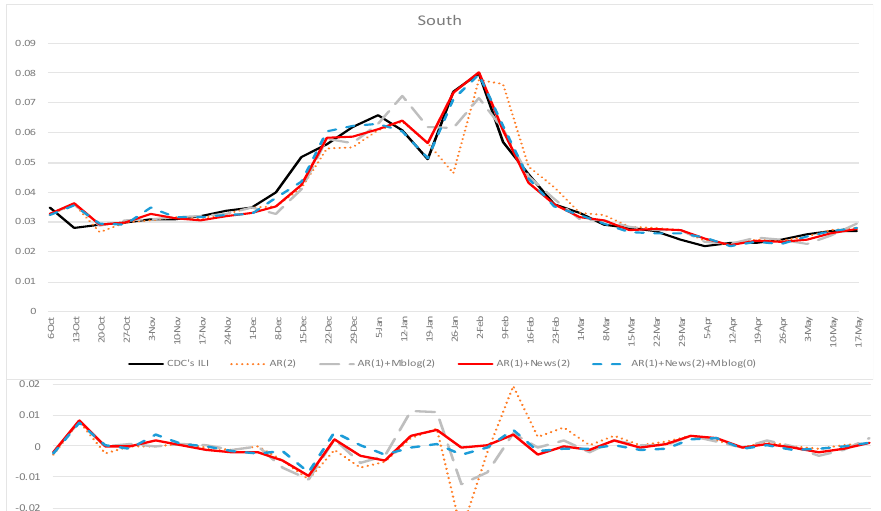
Figure 3. Forecasting results for the south of mainland China, 6 October 2019–17 May 2020. The weekly estimations of AR(2) (dotted orange), AR(1) + Mblog(2) (long dashed gray), AR(1) + News(2) (red), and AR(1) + News(2) + Mblog(1) (dashed blue) models were compared against the CNIC’s ILI rates (black). Bottom: The estimation error, defined as the estimated value minus the CNIC’s ILI rates.